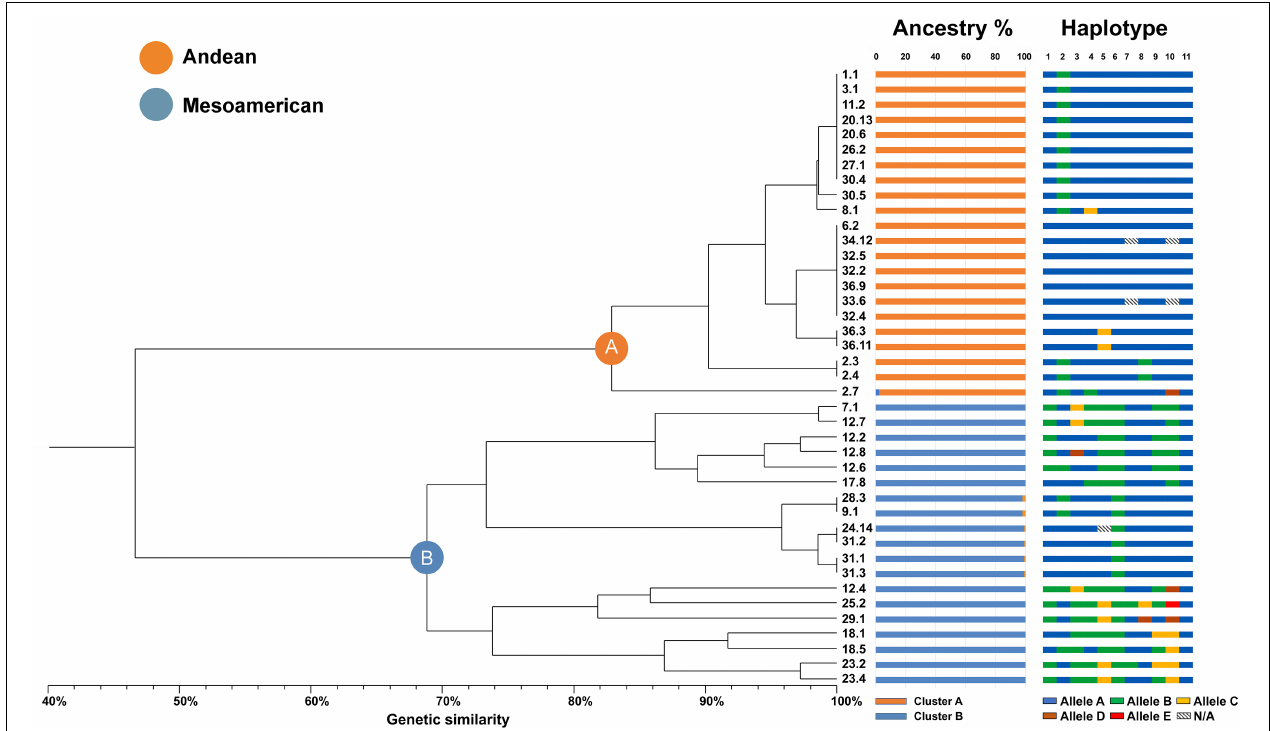
FIGURE 2 | UPGMA dendrogram with all the common bean accessions analyzed in this study grouped in two main clusters (A,B) and several subclusters. The ancestry colored bars refer to the percentage of ancestral membership estimated by STRUCTURE analysis (for k = 2). The haplotype colored bars refer to the allele combinations found for each of the samples: individual bars are split into eleven blocks as the number of sequenced genes and each bar as a whole represents a multi-locus haplotype including 11 specific alleles (dashed blocks indicate missing data).